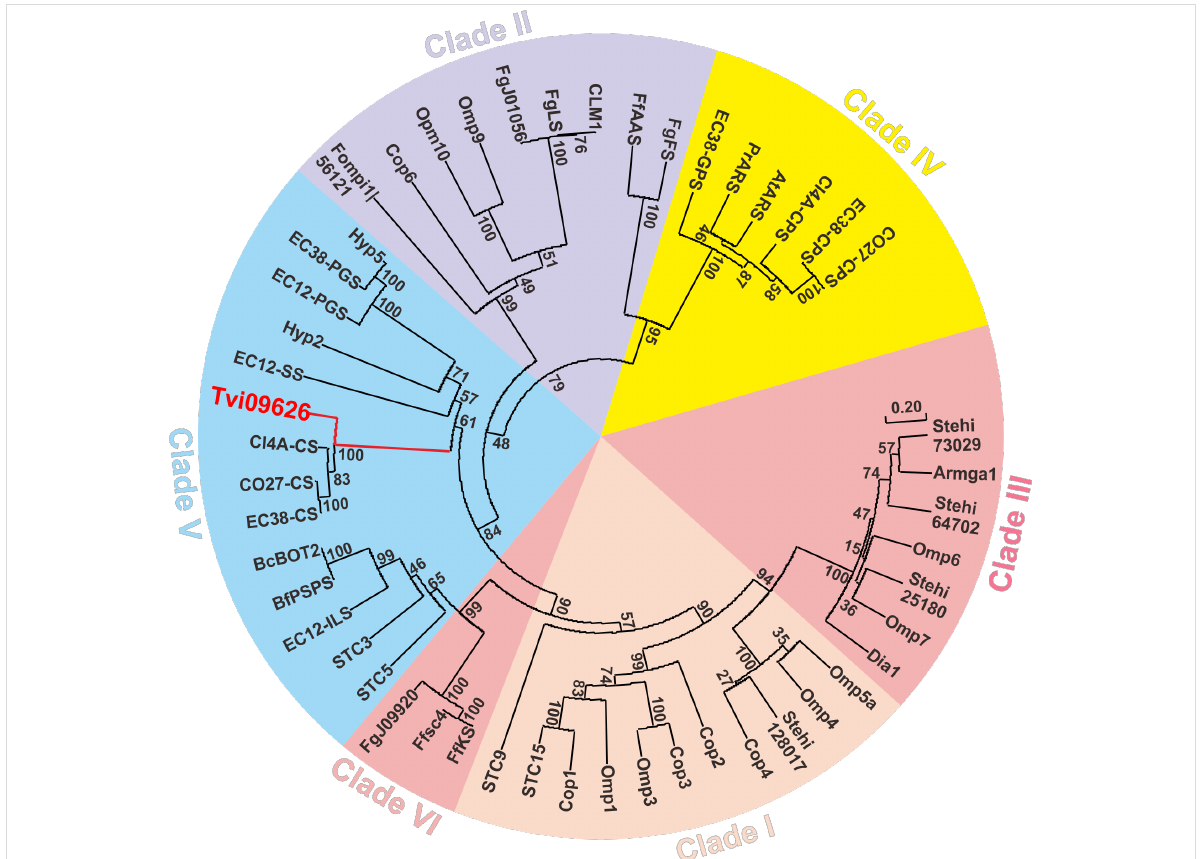
Figure 2: Phylogenetic analysis of Tvi09626 with other characterised terpene synthases. Six clades are marked with different colours and Tvi09626 is labelled in red in Clade V. Percentages indicate branch support based on 1,000 bootstrap replicates.